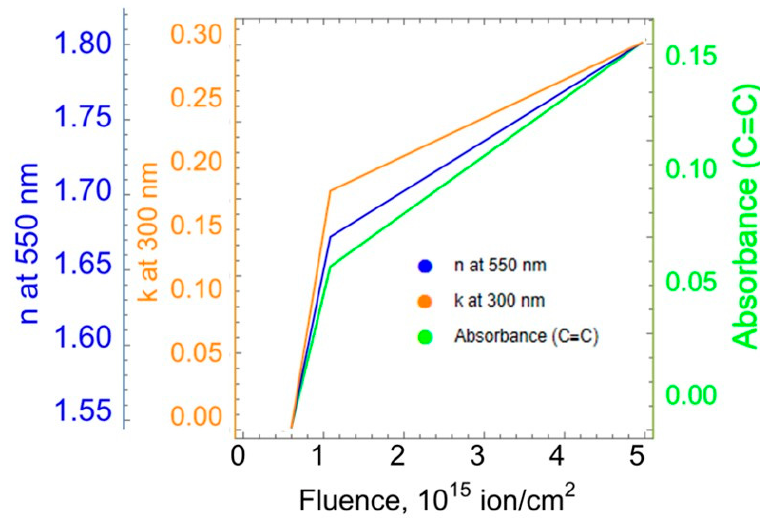
Figure 11. Refraction index at the wavelength of 550 nm (n: blue curve) and extinction coefficient at the wavelength of 300 nm (k: orange curve) of the carbon layer as a function of the fluence of polyurethane plasma treatment; intensity of absorbance (green curve) of lines n(C=C) in the FTIR ATR spectra of polyurethane as a function of the fluence of plasma treatment.